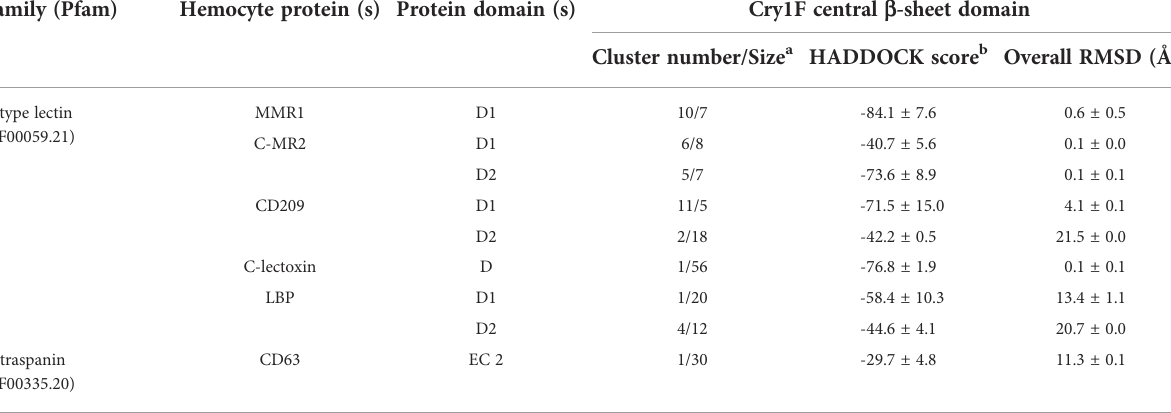
TABLE 2 PPI and clustering scores of Cry1F homology model in complex with C-type lectins and tetraspanin proteins. Family (Pfam) Hemocyte protein (s) Protein domain (s)